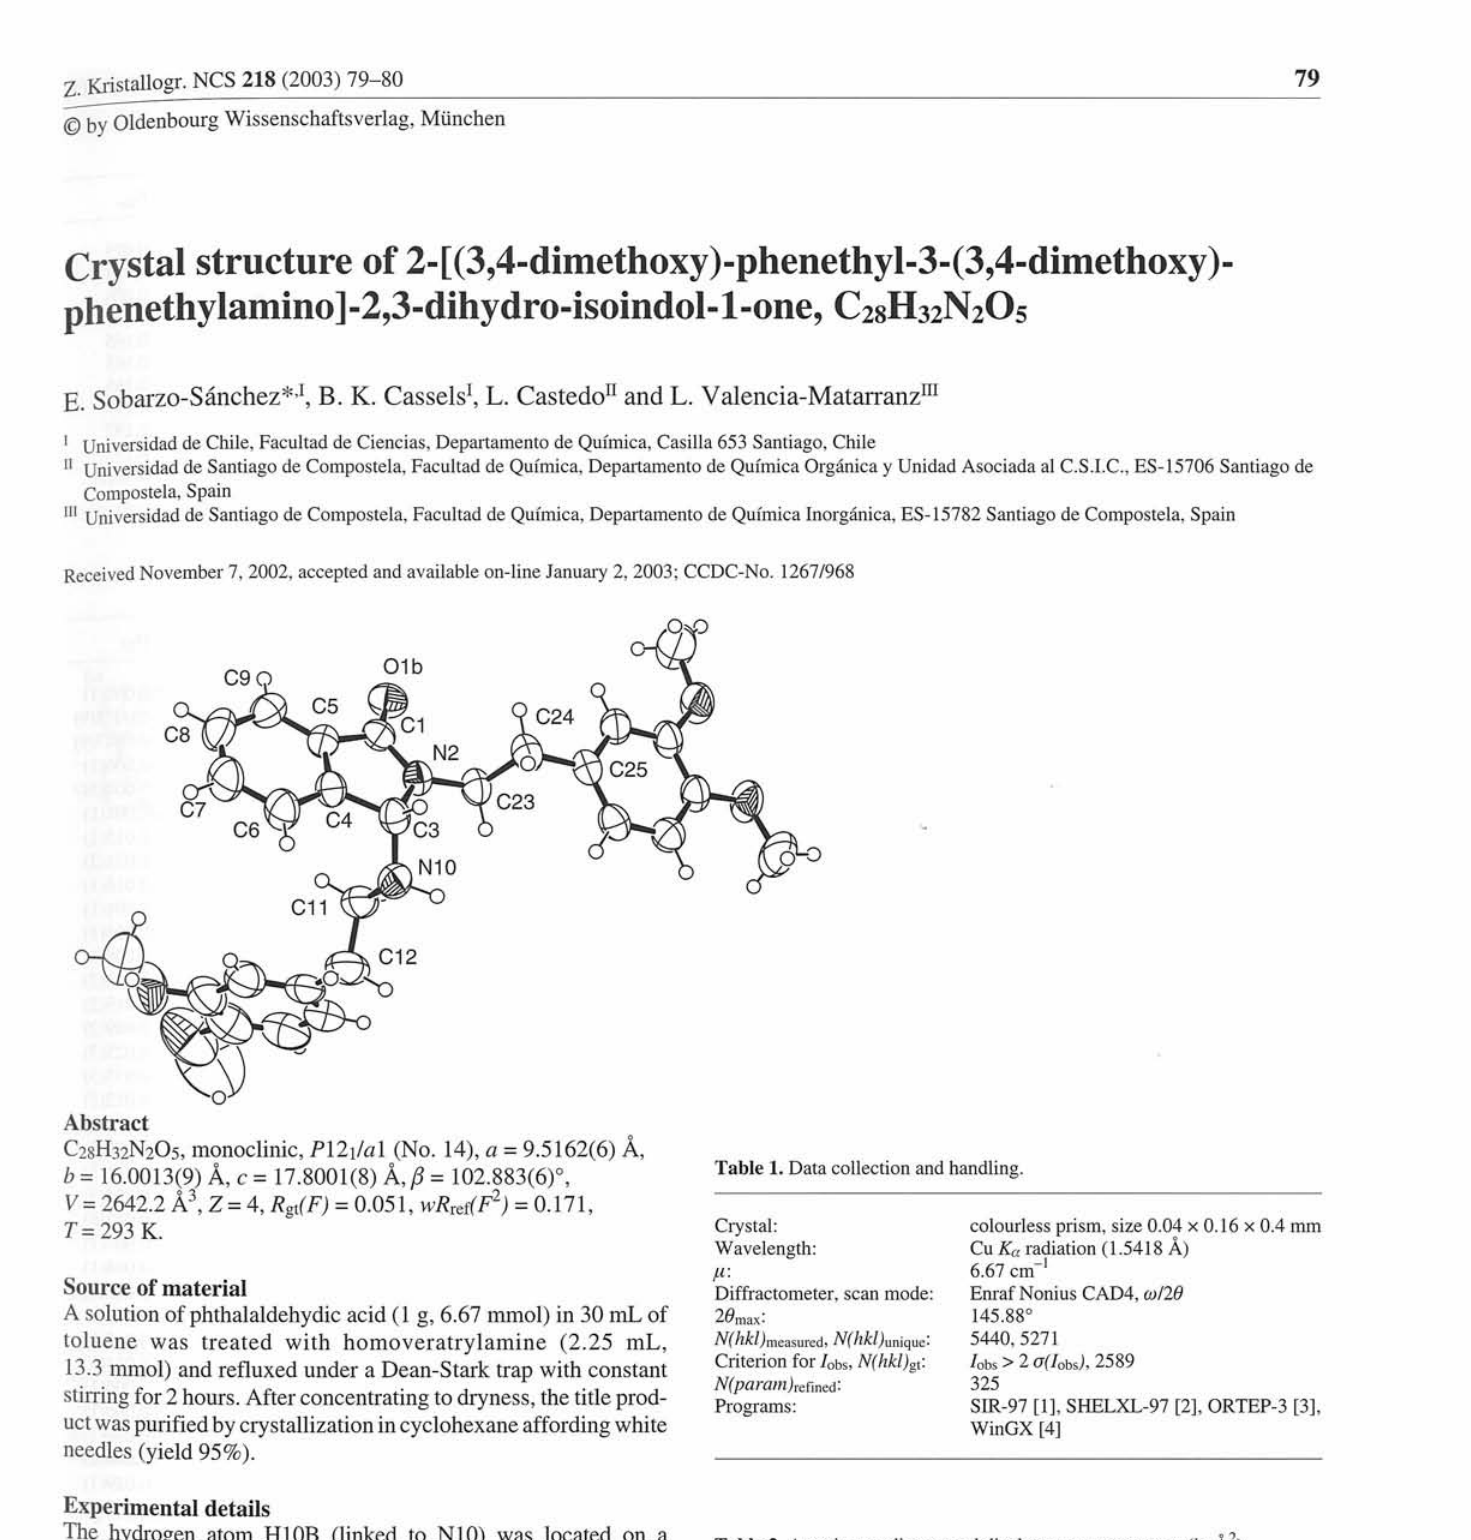
Table 2. Atomic coordinates and displacement parameters (in Â 1